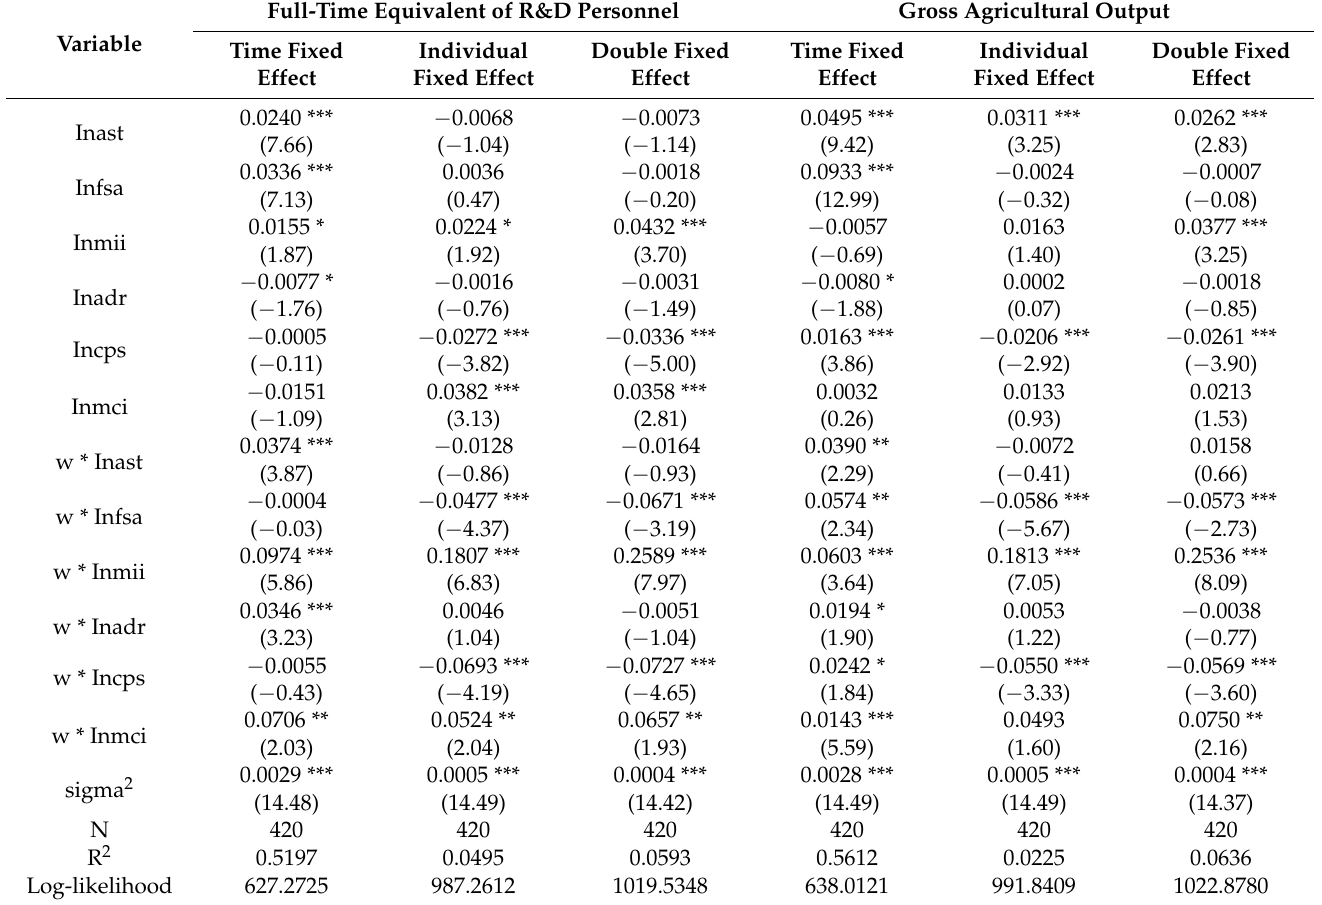
Table 14. The spatial panel econometric regression results of agricultural science and technology innovation on agricultural green development under the economic matrix.